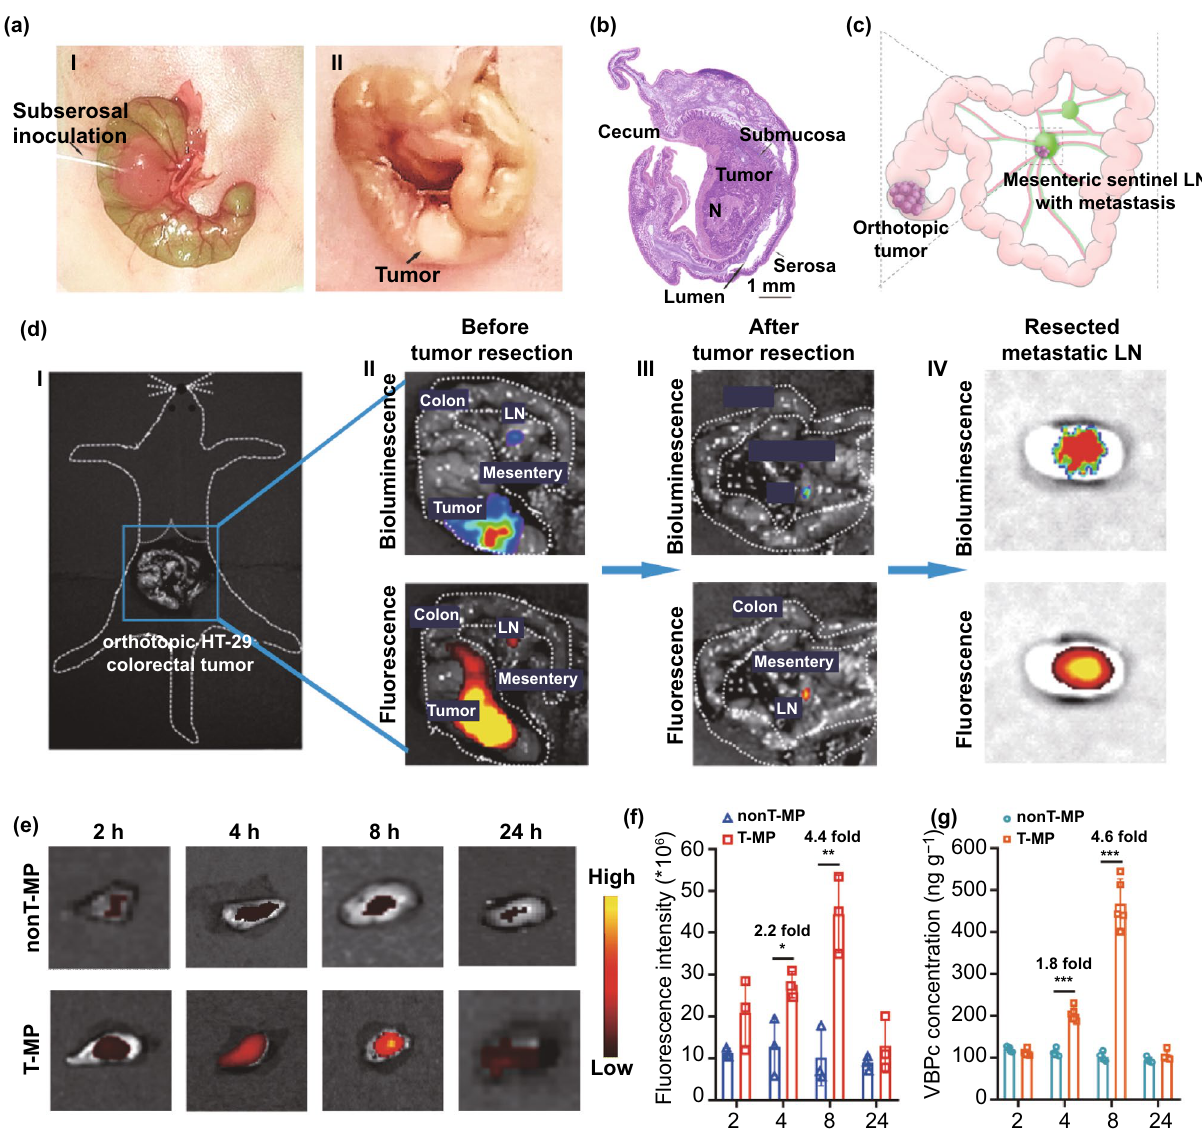
Fig. 3 Orthotopic HT‑29‑luc colorectal cancer model and metastatic LN targeting of T‑MP. a Establishment of orthotopic HT‑29‑luc tumor by sub‑serosal injection of tumor cells in the cecum (I). The solid tumor was visible to the naked eye after 2 weeks (II). b Hematoxylin and eosin (H&E) staining showed the right anatomical location of the orthotopic tumor. c Illustration of the metastatic sentinel LN in the mesentery. d The metastatic mesenteric sentinel LN was targeted and imaged using Cy5.5‑labeled T‑MP after intravenous administration. (I), Illustration of the orthotopic HT‑29‑luc tumor in mouse abdominal cavity. (II), Bioluminescent and fluorescent imaging of the orthotopic tumor and metastatic sentinel LN. (III), Bioluminescent and fluorescent imaging of the metastatic sentinel LN after tumor resection. (IV), Ex vivo imaging of the excised metastatic sentinel LN. e Time‑dependent, ex vivo imaging of the Cy5.5‑labeled micelles in the metastatic sentinel LNs. f Quantified fluorescence intensity in panel E. g VBPc contents in metastatic sentinel LN. Data are presented as mean ± s.d. n = 3 in panel F and 5 in panel G. * p < 0.05, ** p < 0.01, *** p <